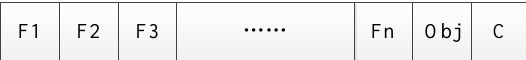
Figure 3. Initial solution example by SFS after encoding.